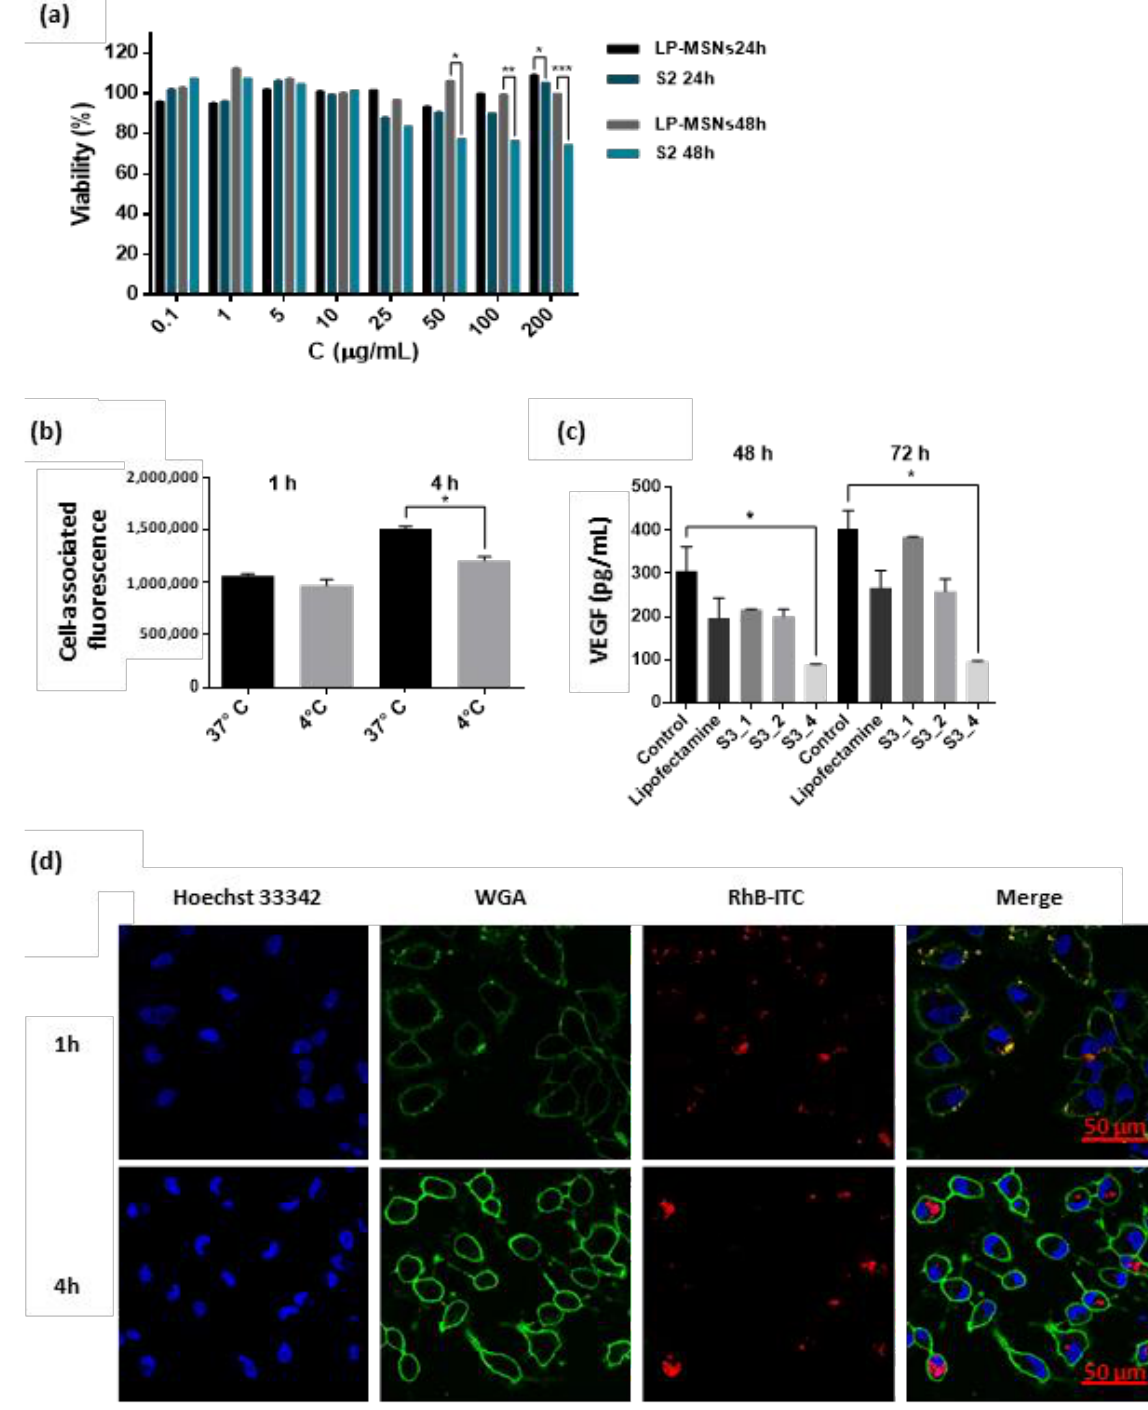
Figure 2. Biological validation of the developed nanomaterials. ( a ) ARPE-19 cell viability after 24 or 48 h of incubation with different concentrations of LP-MSNs or S2 nanoparticles. Plates were analysed by measuring absorbance at 490 nm after 1 h of further incubation with cell proliferation reagent WST-1. Data are expressed as means ± s.d. Asterisks indicate significant differences (* = p < 0.05, ** = p < 0.01, *** = p < 0.001) when the t-test was applied. ( b ) Cell-associated fluorescence over time of ARPE-19 cells treated with 50 μg/mL of S2 and incub ated at 37 °C or 4 °C is represented. Data are expressed as means ± s.d. Asterisks indicate significant differences ( p < 0.01) when the t-test was applied. ( c ) VEGF levels (pg/mL) in ARPE-19 cell supernatant after transfection with 100 nM siRNA/lipofectamine complex or treatment with 1× (S3_1), 2× (S3_2), or 4× (S3_4) the amount of siRNA in lipofectamine complex. Data are expressed as means ± s.d. Asterisks indicate significant differences ( p < 0.05) when the t-test was applied. ( d ) Representative confocal microscopy images of ARPE-19 cells after 1 or 4 h of incubation at 37 °C with 50 μg/mL of S2. Cell nuclei are stained with Hoechst 33342 (blue) and cellular membrane with wheat germ agglutinin (WGA) (green). S2 nanoparticles are labelled with RhB-ITC (red).